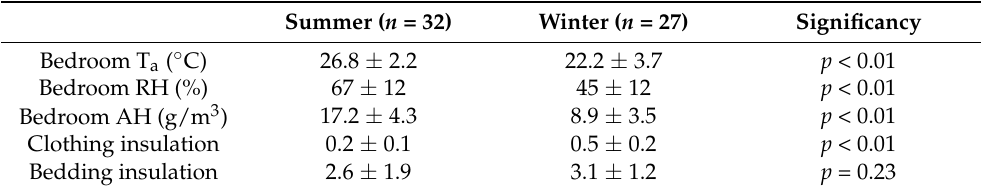
Table 3. Average indoor thermal environment of participant’s bedroom and outdoor thermal envi- ronment.